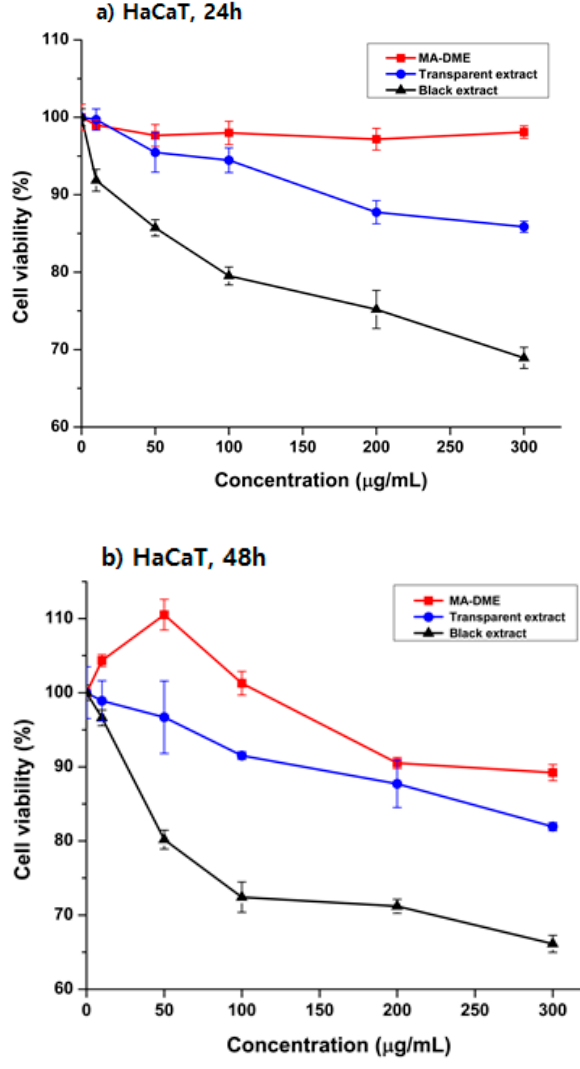
Figure 3. The effect of MA-DME on the viability of HaCaT cells compared with Black extract and Transparent extract for ( a) 24 h, ( b ) 48 h. The viability of MA-DME (10 to 300 µ g/mL) was measured via MTT assay, n = 3.